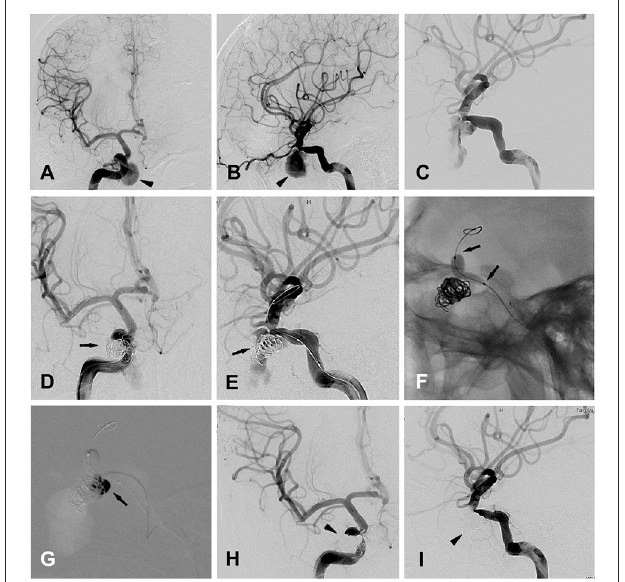
FIGURE 2 | Patient 12 (A,B) anteroposterior (A) and lateral (B) views of the right ICA angiogram for initial diagnosis, showing a traumatic cavernous pseudoaneurysm (black arrow head). (C) The second time of right ICA angiogram before the embolization, showing the formation of the thrombus in the false cavity of the pseudoaneurysm. (D,E) Anteroposterior (A) and oblique (B) views of the right ICA angiogram, showing the placement of endovascular coils in the pseudoaneurysm (black arrows), with the embolization microcatheter directing toward the pseudoaneurysm’s cavity. (F) Balloon inflation (black arrows) was accomplished with the saline/contrast mixture. (G) Intraprocedural road map during the injection of the onyx (black arrow) into the pseudoaneurysm’s cavity, after the complete cover of the pseudoaneurysm’s ostium by the inflated balloon. (H,I) Anteroposterior (A) and oblique (B) views of the right ICA angiogram, showing the traumatic pseudoaneurysm completely occluded by the coils and onyx embolization (black arrow heads).